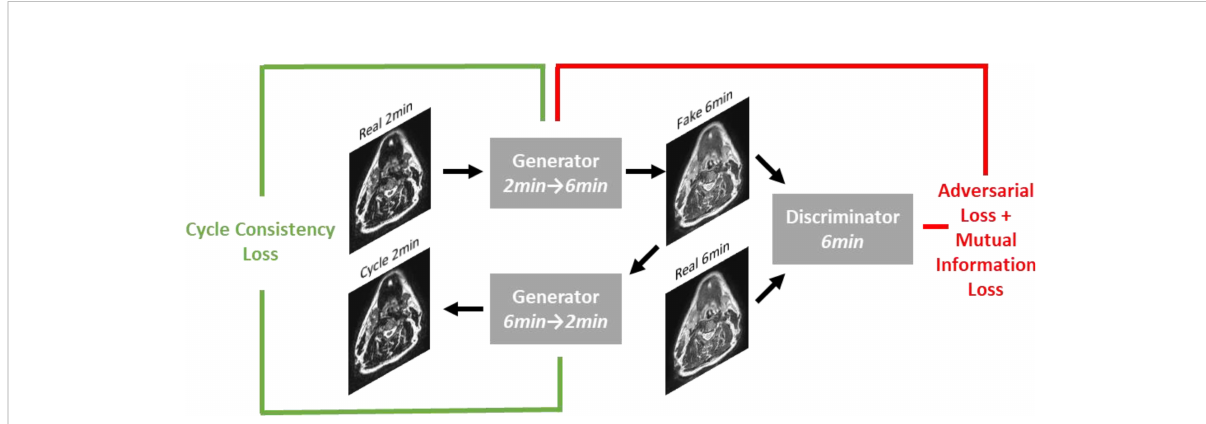
FIGURE 2 Overview of loss functions used in deep learning network. For simplicity, only the fi rst half of the CycleGAN is shown where a fake 6-minute scan is generated from a real 2-minute scan. An analogous process occurs to generate a fake 2-minute scan from a real 6-minute